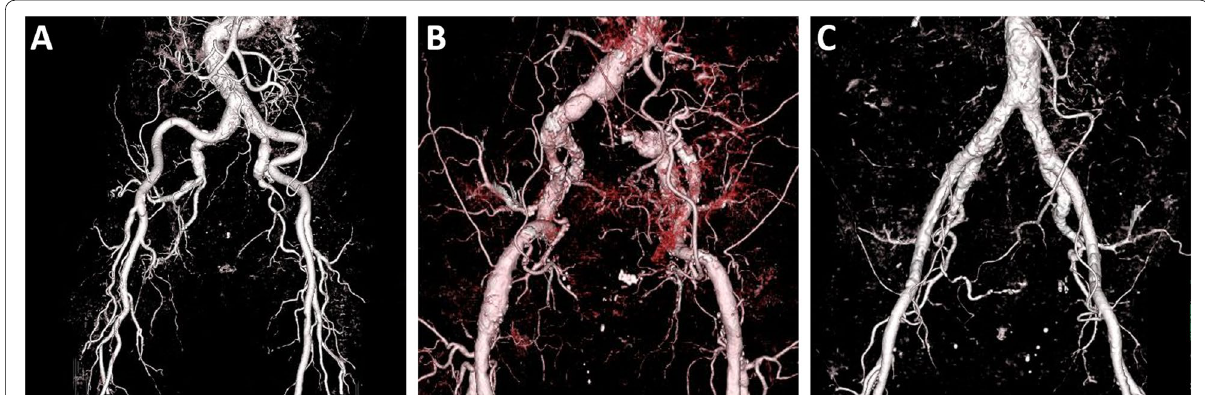
Fig. 1 Three-dimensional computed tomographic images of the pelvic level from the 2 patients with postoperative paraplegia (SCI patient 1 and SCI patient 2 in a and b , respectively) and a patient without postoperative paraplegia (no-SCI patient, c ). SCI patient 1: ABI was 0.71/1.23 (right superficial femoral artery occlusion). No. of hypogastric arteries was 45 and 21 at the right side and left side, respectively. SCI patient 2: ABI was 1.05/0.64 (left common iliac artery occlusion). No. of hypogastric arteries was 28 and 38 at the right side and left side, respectively. No-SCI patient: